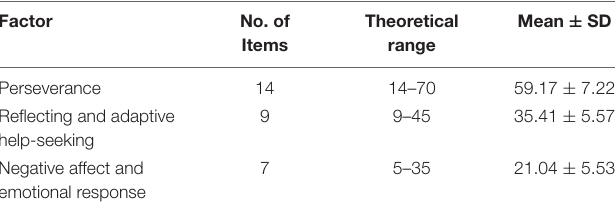
TABLE 5 | Mean and standard deviation ARS-30 scores by factor.